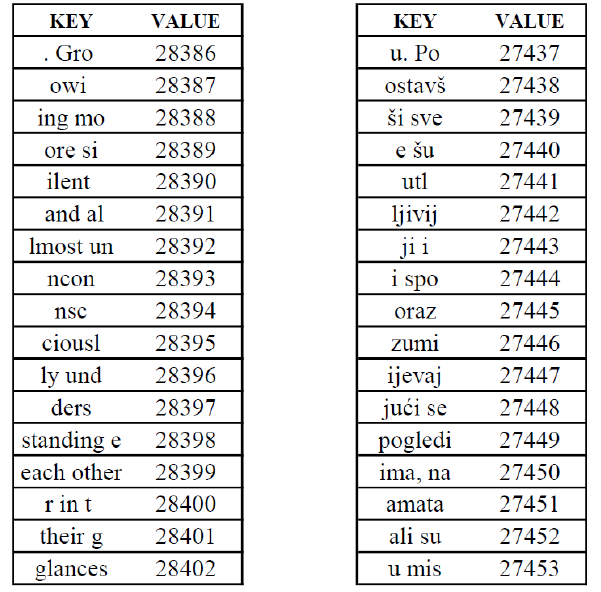
Figure 15. Example from LZW dictionaries in English and